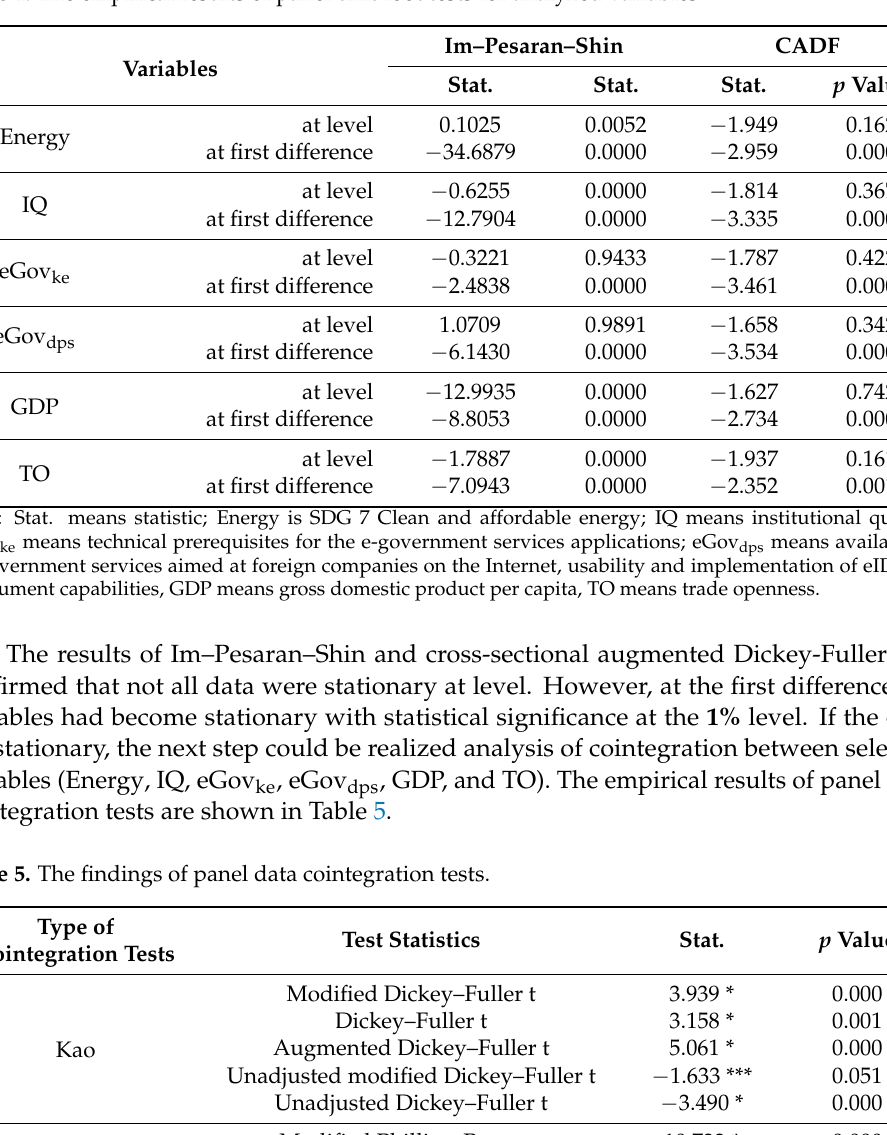
Table 4. The empirical results of panel unit root tests for analyzed variables.